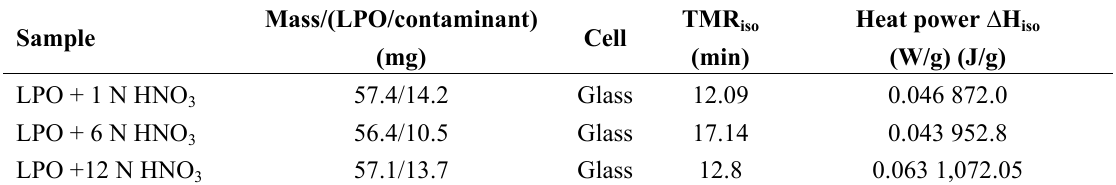
Table 4. Experimental data by TAM III tests for 95 mass% LPO with various concentrations of HNO at 70 °C. 3